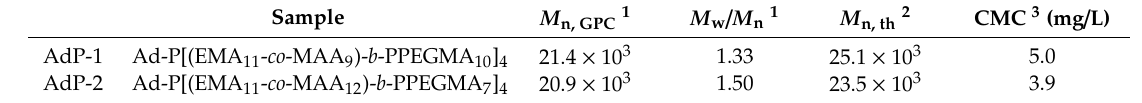
Table 1. Characterization of Ad-P[(EMA- co -MMA)- b -PPEGMA] 4 .